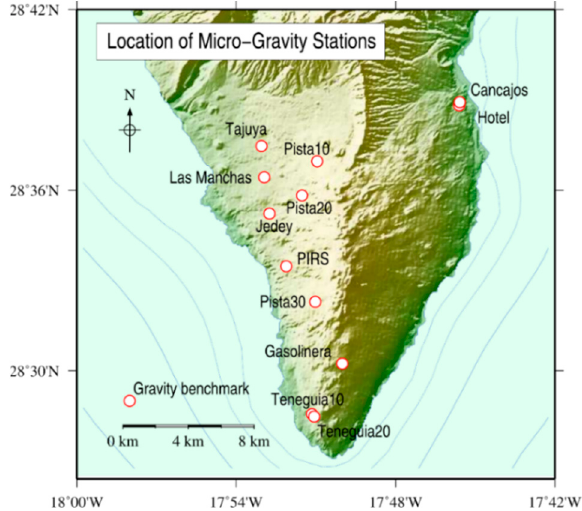
Figure 8. Geographic locations of the 12 micro-gravity locations on La Palma.